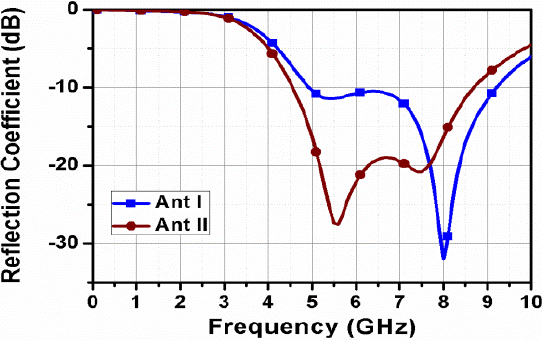
10 of 27 Figure 10. Evolution of the antennas linked with P10 to P17. In Equation (2), l2 and p3 are the length of the rectangular patch and feed gap in centimeters, respectively. The term ‘r 2 ′ in centimeters can be calculated from the width of the rectangular patch since r2 = 𝑤2 2𝜋 . The term ‘k’ is constant and is equal to 1.15. After finding out the values of l2, r2, p3 and k, the LBE frequency of Ant I in Figure 10 is found